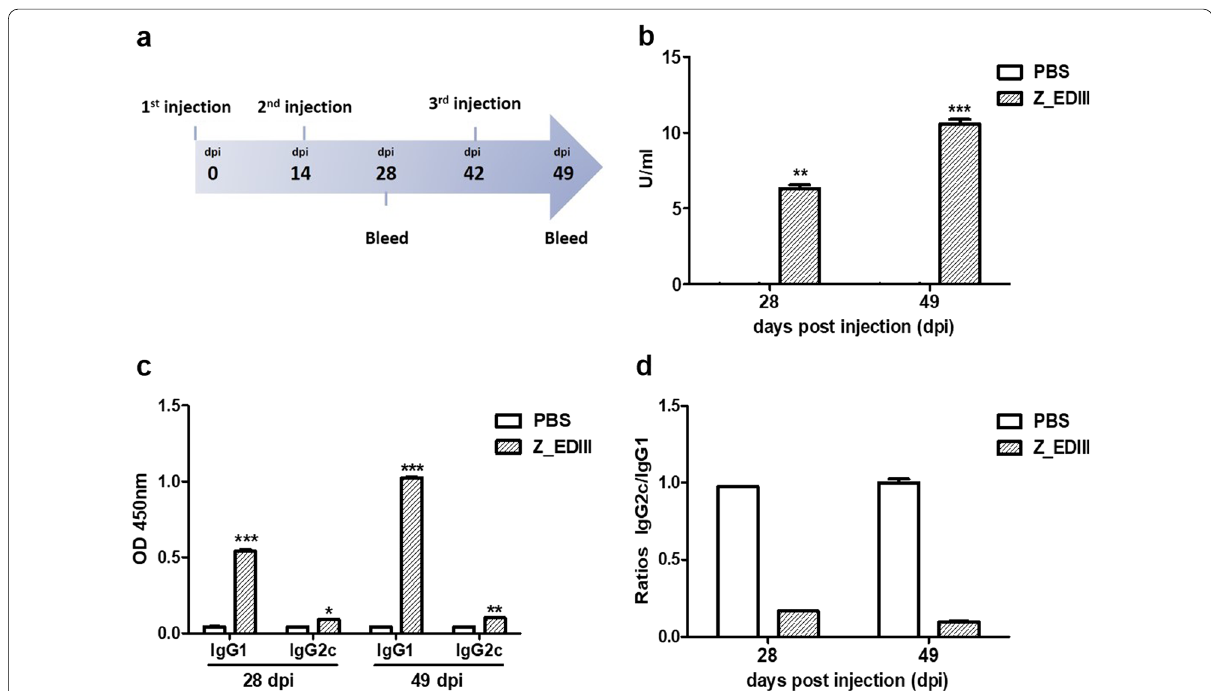
Fig. 2 ZIKV envelope protein domain III‑specific antibody responses elicited by Z_EDIII. a Experimental strategies. C57BL/6 mice ( n were immunized with Z_EDIII or PBS at 0, 14, and 42 dpi. For Ag‑specific IgG antibodies, blood samples were collected at 0, 28, and 49 dpi. b Serum samples were diluted (1:50,000) and OD 450 values were measured using ZIKV envelope protein domain III‑coated ELISA kit. The ZIKV envelope protein domain III‑specific IgG antibody activity units were calculated. c Serum samples were diluted (1:100) and OD 450 values were measured.